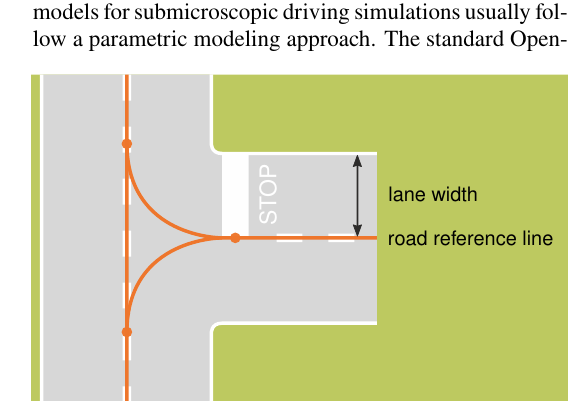
Figure 7. Parametric representation of a road crossing DRIVE uses lines, clothoids, arcs and (parametric) cubic curves for constructing a road’s reference line, as shown in Figure 7. This enables the modeling of roads with continu- ous curvatures and also adheres to the process of